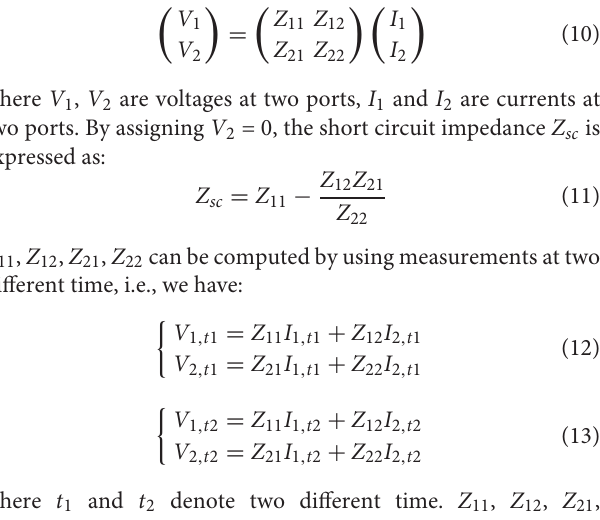
FIGURE 2 | Transformer with bushing